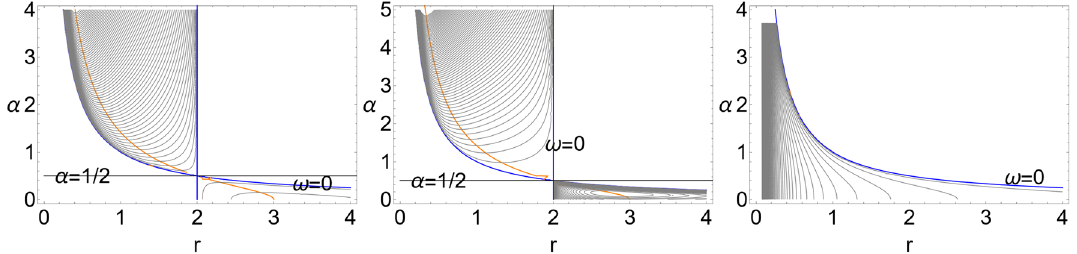
Fig. 6 Metric bundles for the C- metric of Eq. (18)-left panel and of Eq. (20)-center panel on the equatorial plane. There is M = 1 and θ = π/ 2, α is the acceleration parameter and ω = 0 sets the horizons (blue curve). Blue curves are the BH horizons, r = 2, and the acceler-